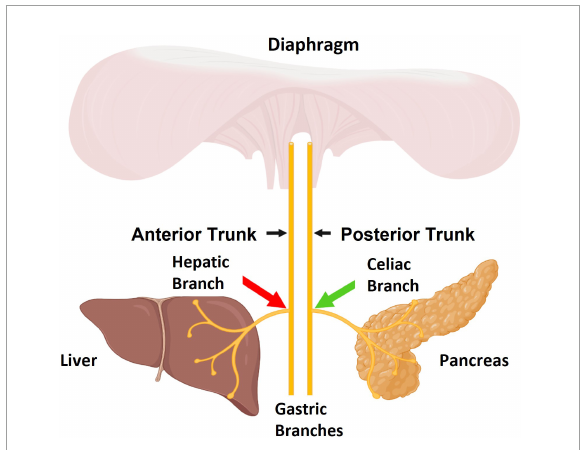
FIGURE1 The sub-diaphragmatic Vagus nerve consists of two major trunks, the anterior and posterior. The pancreas is primarily innervated by the celiac branch which stems from the posterior Vagal trunk. The liver is innervated by the hepatic branch which stems from the anterior Vagal trunk. The aim of this study was to apply stimulation to celiac fibers (green arrow) and apply high frequency alternating current (HFAC)-induced blockade to hepatic fibers (red arrow). Figure created by